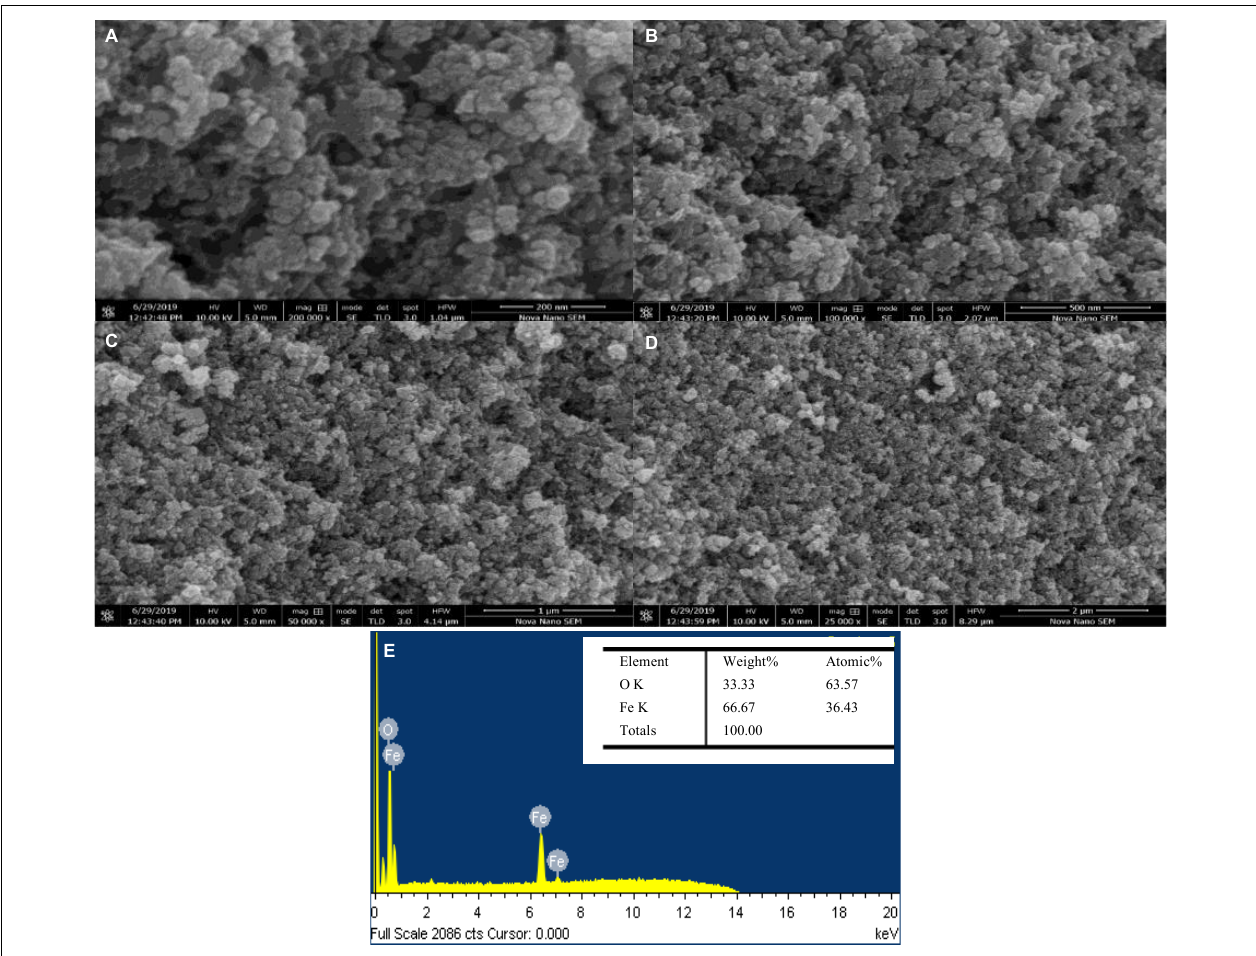
FIGURE 10 | SEM images (A–D) of green-synthesized BC-Fe 3 O 4 NPs at different magnifications (200 and 500 nm and 1 and 2 µ m). EDX spectra (E) of BC-Fe 3 O 4